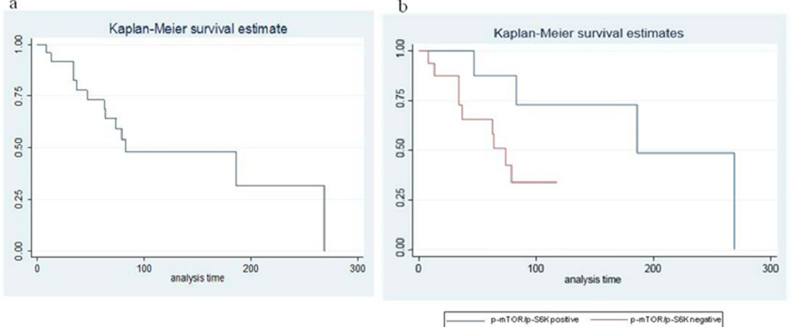
Figure 3. Survival from diagnosis of advanced disease in the whole series (a) and according to p-mTOR/p-S6K expression (b). Table 2. Univariate Cox regression analysis.